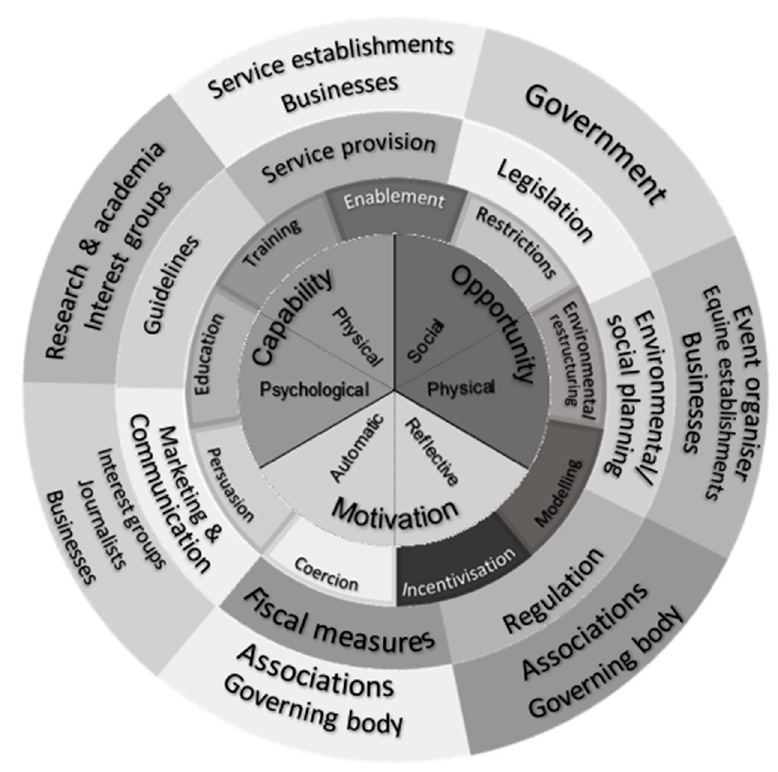
Figure 3. Original Behaviour Change Wheel [33] populated with stakeholders relevant to equestrianism.